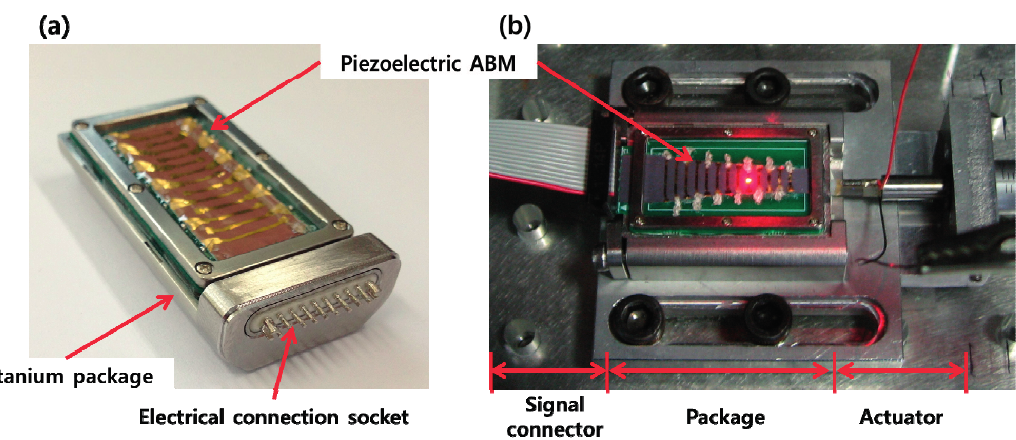
Figure 12. Fabrication and test setup result of the PAC: the fabricated biocompatible PAC ( a ); test setup of PAC device ( b ).